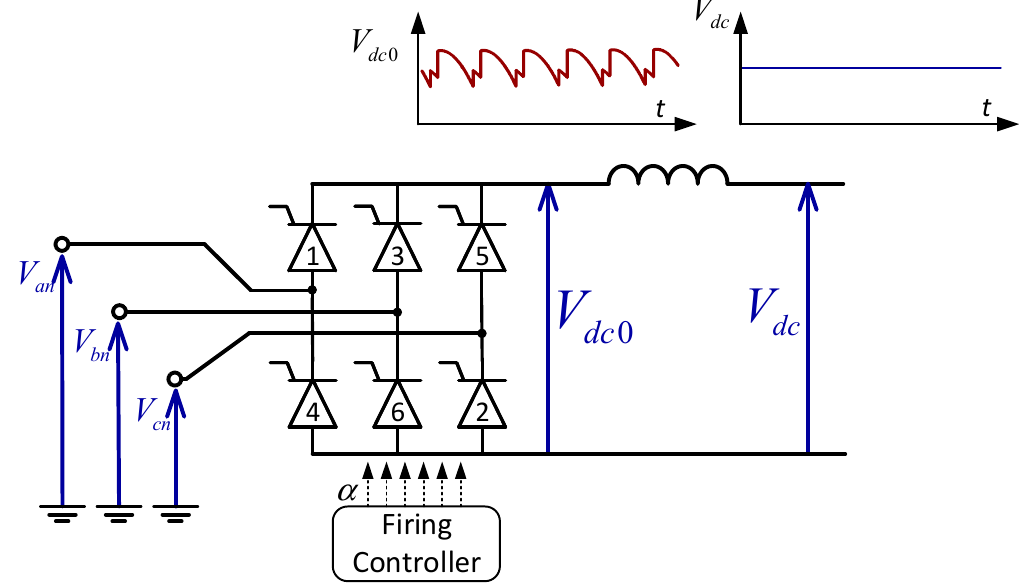
Figure 5. A 6-pulse (Graetz) bridge as a Current Source Converter (CSC).